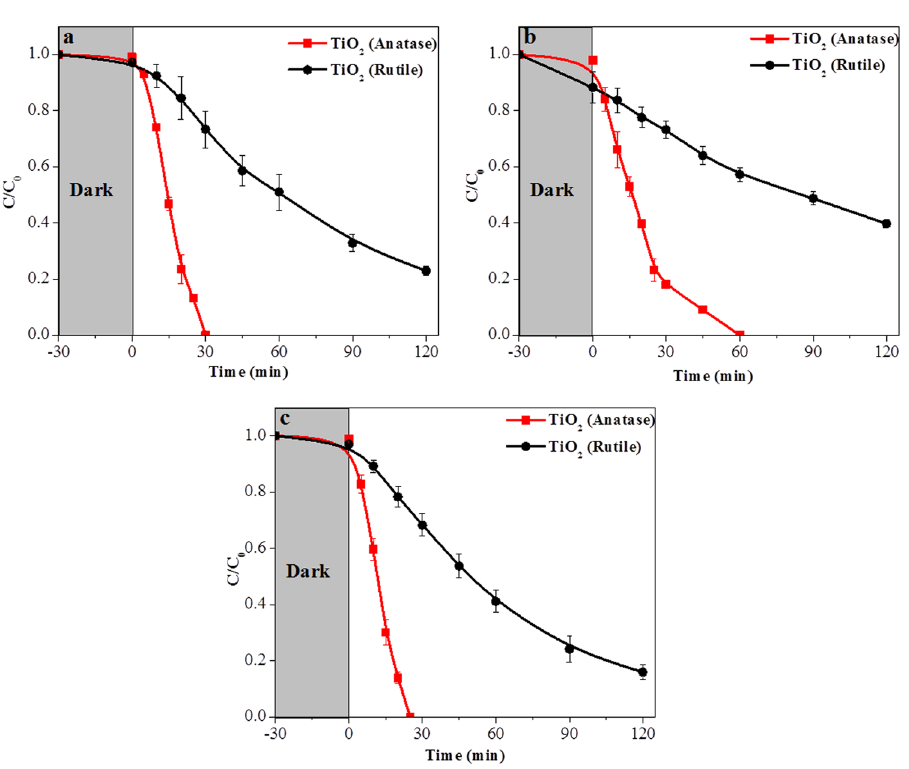
Figure 5. Photocatalytic reduction of ( a ) nitrobenzene, ( b ) 2-nitrotoluene, and ( c ) 2-fluoro-nitrobenzene under anaerobic